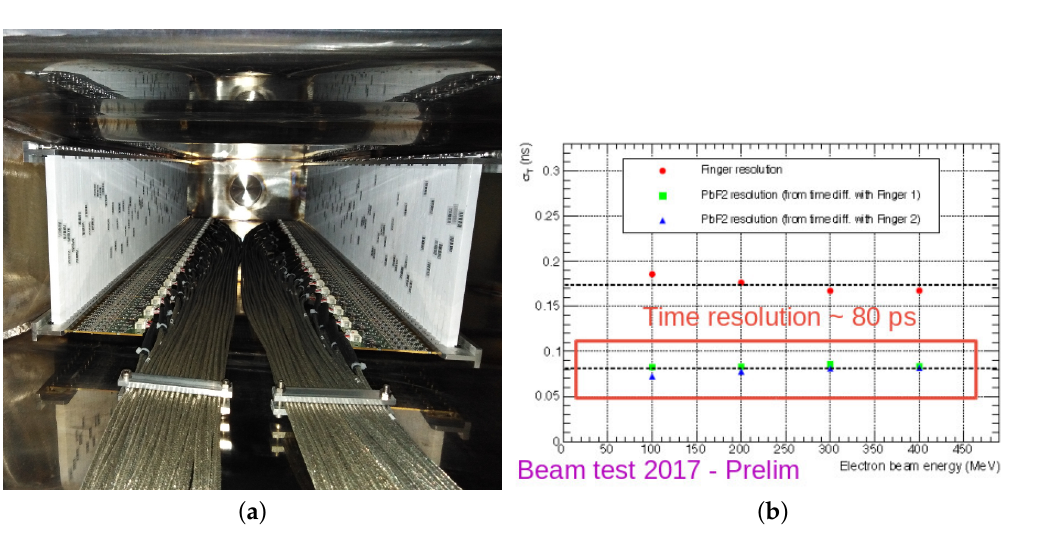
Figure 6. ( a ) Mounted Eveto and Pveto inside vacuum chamber; and ( b ) MIMOSA setup with full